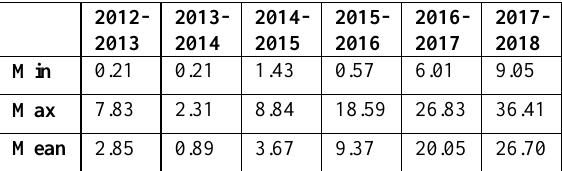
Table 1: Statistics of the aquatic macrophytes fractional area cover spread during 2012-2018 using LISS-III dataset Maximum extent was observed in February-March of every year, while minimum was observed just after monsoon during October. Figure 4 shows the comparison of extent of hyacinth over the Tapi River during the period 2013-2018 for the maximum extent season (i.e. March of every year). The maximum spread was found close to the Sarthana treatment plan, in comparison to